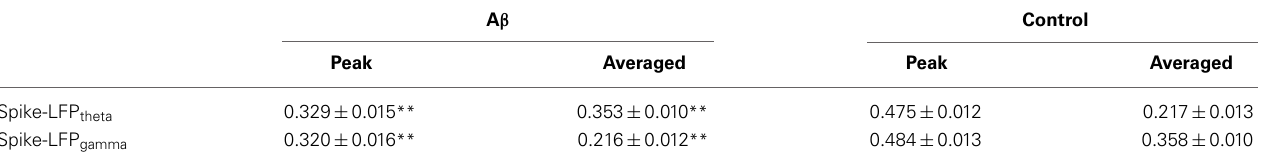
Table 2 | Spike-LFP correlation during working memory task in the A β and control